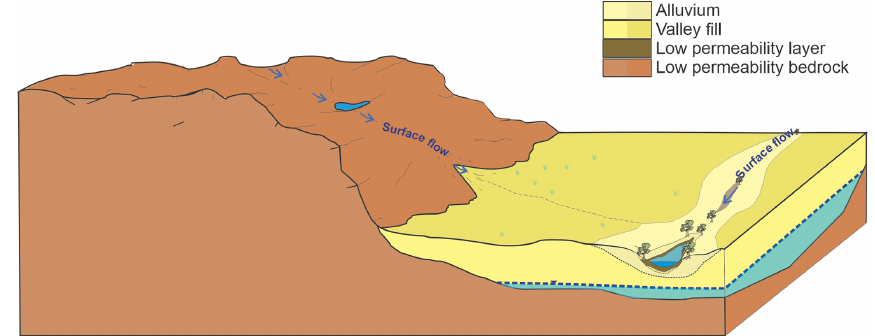
Figure 1. Schematic illustration of perched pools where rainfall–runoff collects in a depression that has morphology that limits evaporation, and/or low permeability lithology beneath the pool that limits infiltration, allowing water to be retained for an extended duration.